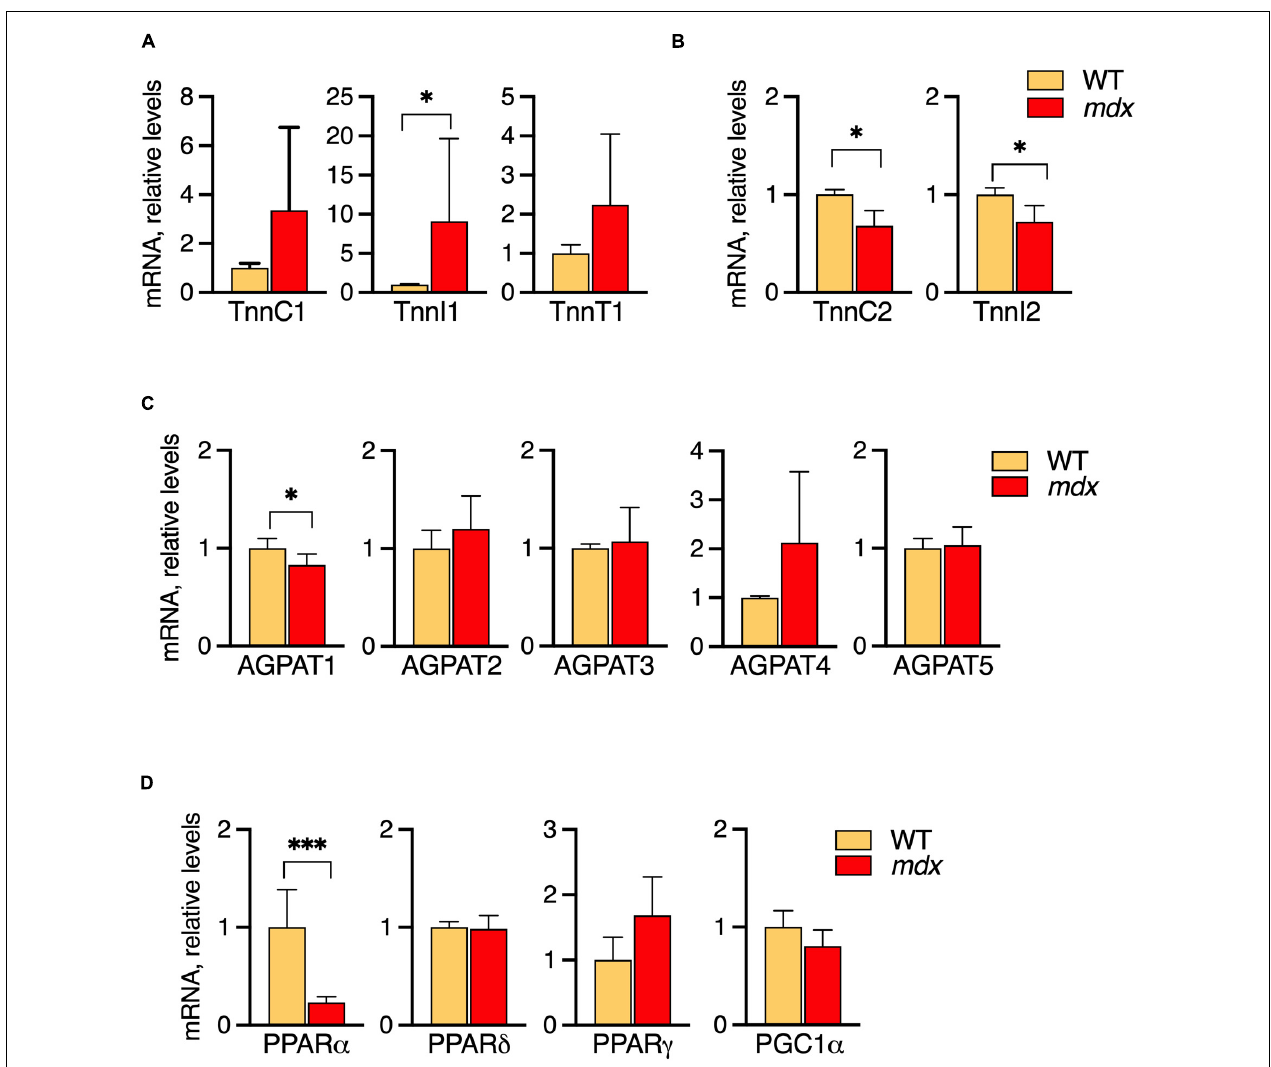
FIGURE 7 | Profiles of mRNA levels of metabolic genes in EDL of 12-week-old B10-WT and - mdx mice raised on CE-2 standard chow. mRNA levels were measured by qPCR and the abundances in mdx tissues relative to those in WT are plotted. High levels of slow-type troponin TnnI1 were observed in the mdx tissues (A) while fast-type troponins TnnC2 and TnnI2 were decreased in mdx tissues (B) . Among several AGPATs, AGPAT1 was slightly decreased in the mdx tissue (C) . Among several PPAR signaling molecules, PPAR α was markedly down regulated in the mdx tissue (D) . The means ± SD are plotted. Significance is based on t -tests. ∗ p < 0.05, ∗∗∗ p < 0.001; n = 4–5